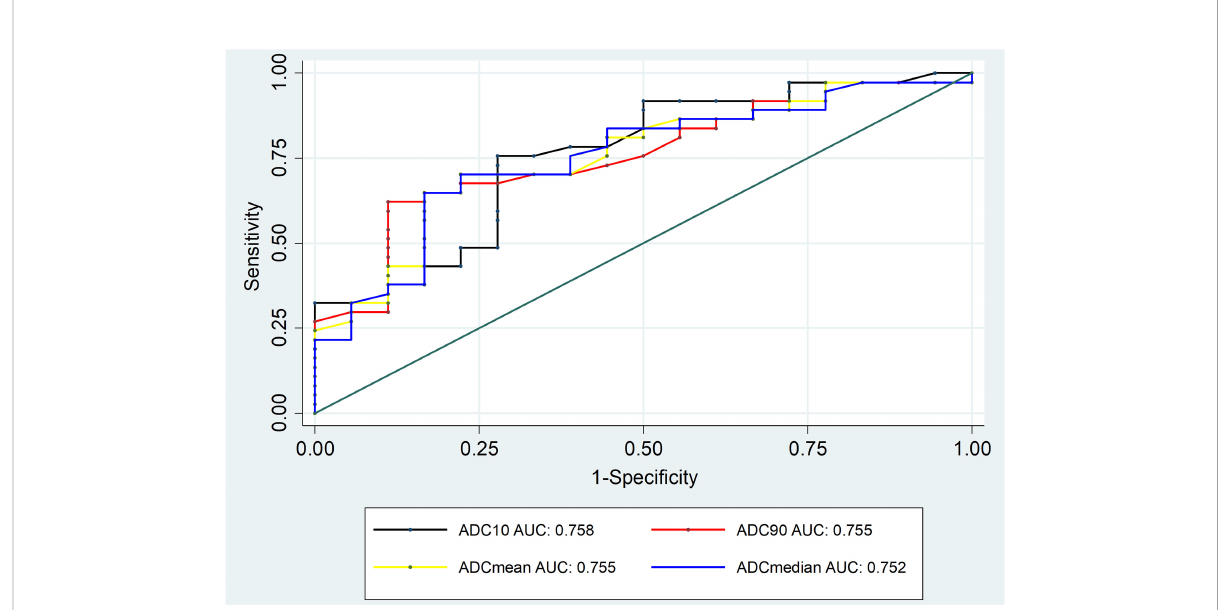
FIGURE 4 ROC curves of histogram-based ADC measurements for differentiating between group A and group B